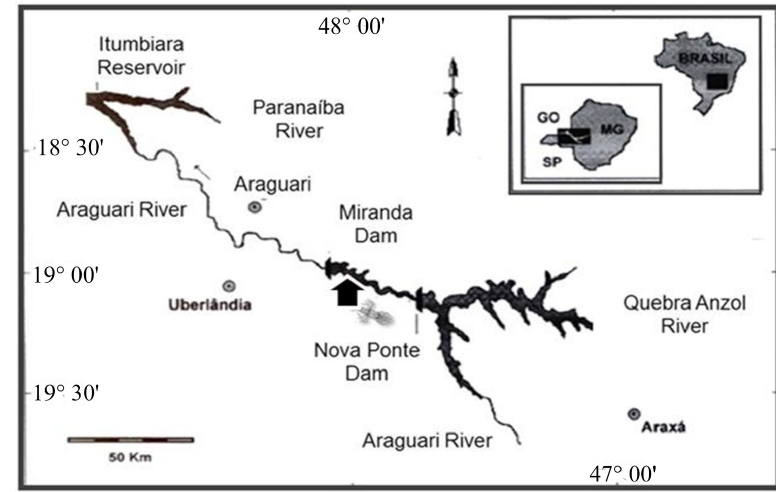
Figure 1. Miranda dam (arrow indicates sampling location) (adapted from Vono et al.,